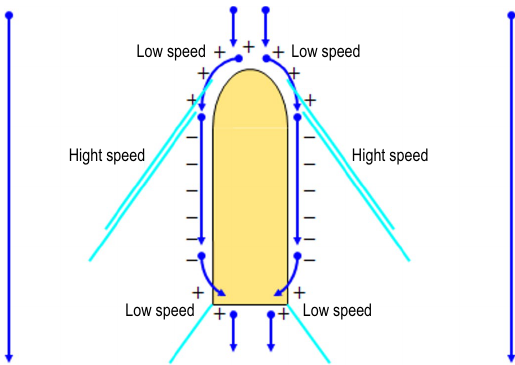
Fig. 2. Pressure distribution around the ship